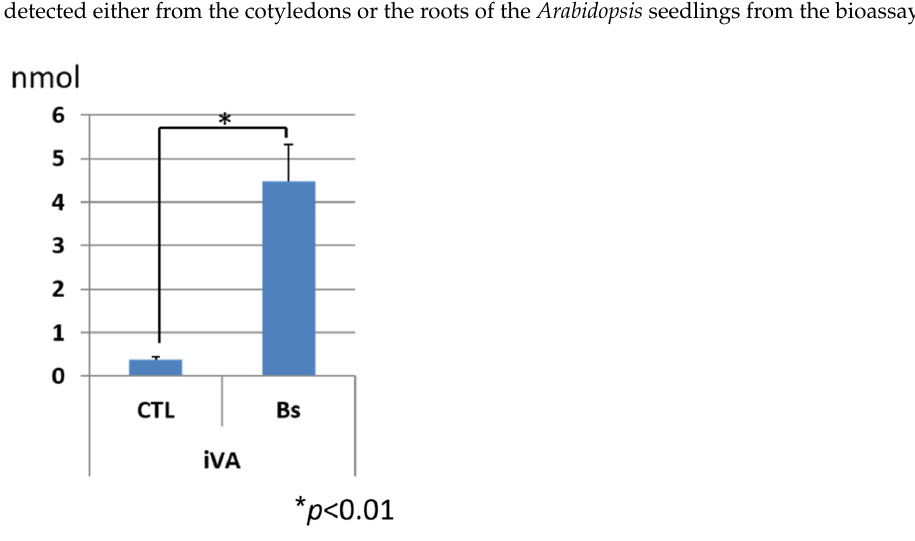
Figure A7. Quantification of IVA released from the Bacillus spp. culture. Bacillus spp. was cultured in a 35 mm dish with agar medium of tryptic soy broth. A 35 mm dish was covered with a rectan- gular petri dish containing 40 ml of NaHCO 3 . After 2 days of culture, the IVA that was released from Bacillus and absorbed in NaHCO 3 was extracted twice with equal volume of methylene chlo- ride, concentrated in a hot water bath (40 degrees), and was subjected to GC–MS analysis. The cal- culation was based on the corresponding peak area of a fragmentation ion of IVA in a mass